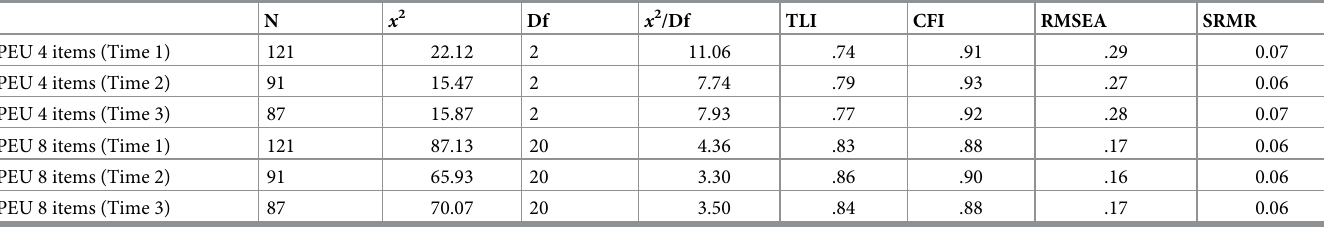
Table 7. Fit statistics for reliability study for PEU 4 and 8 item scales (Study